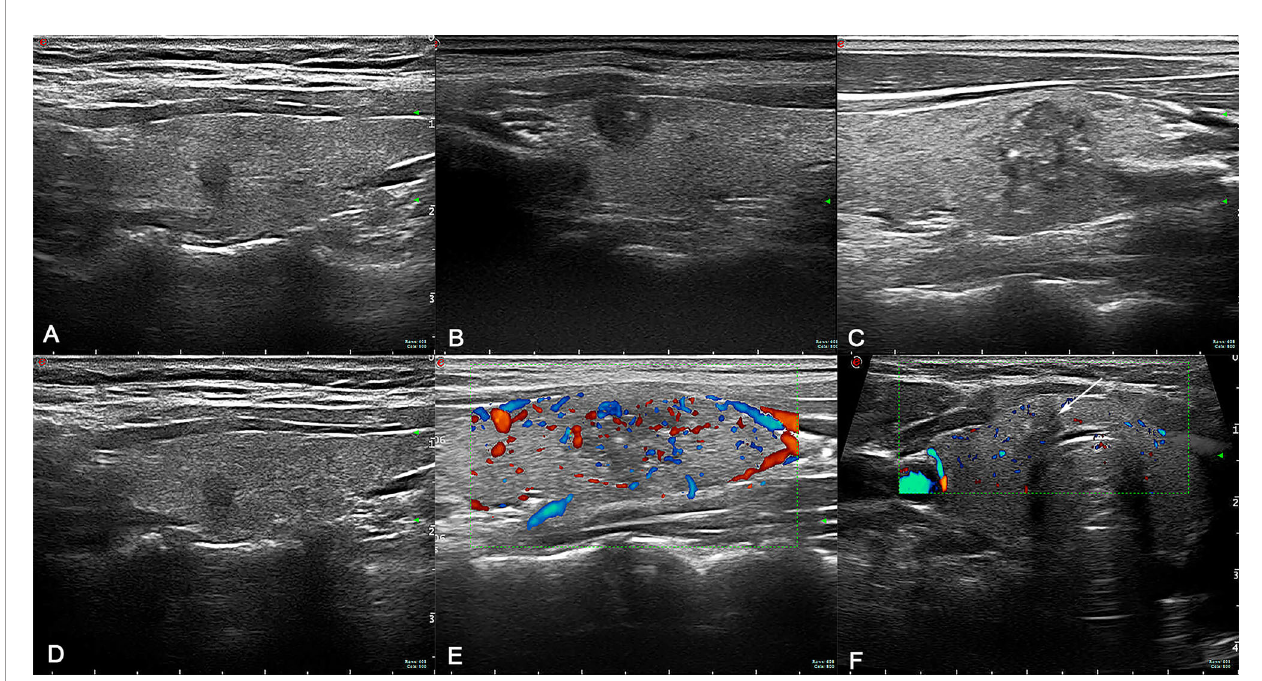
FIGURE 1 | (A) The cancer focusisin the middle. (B) The cancer focusisnear the anteriorcapsule. (C) Lesion with calci fi cation. (D) Lesion without calci fi cation. (E) Lesion with abundant bloodsupply. (F) Lesion with insuf fi cient bloodsupply